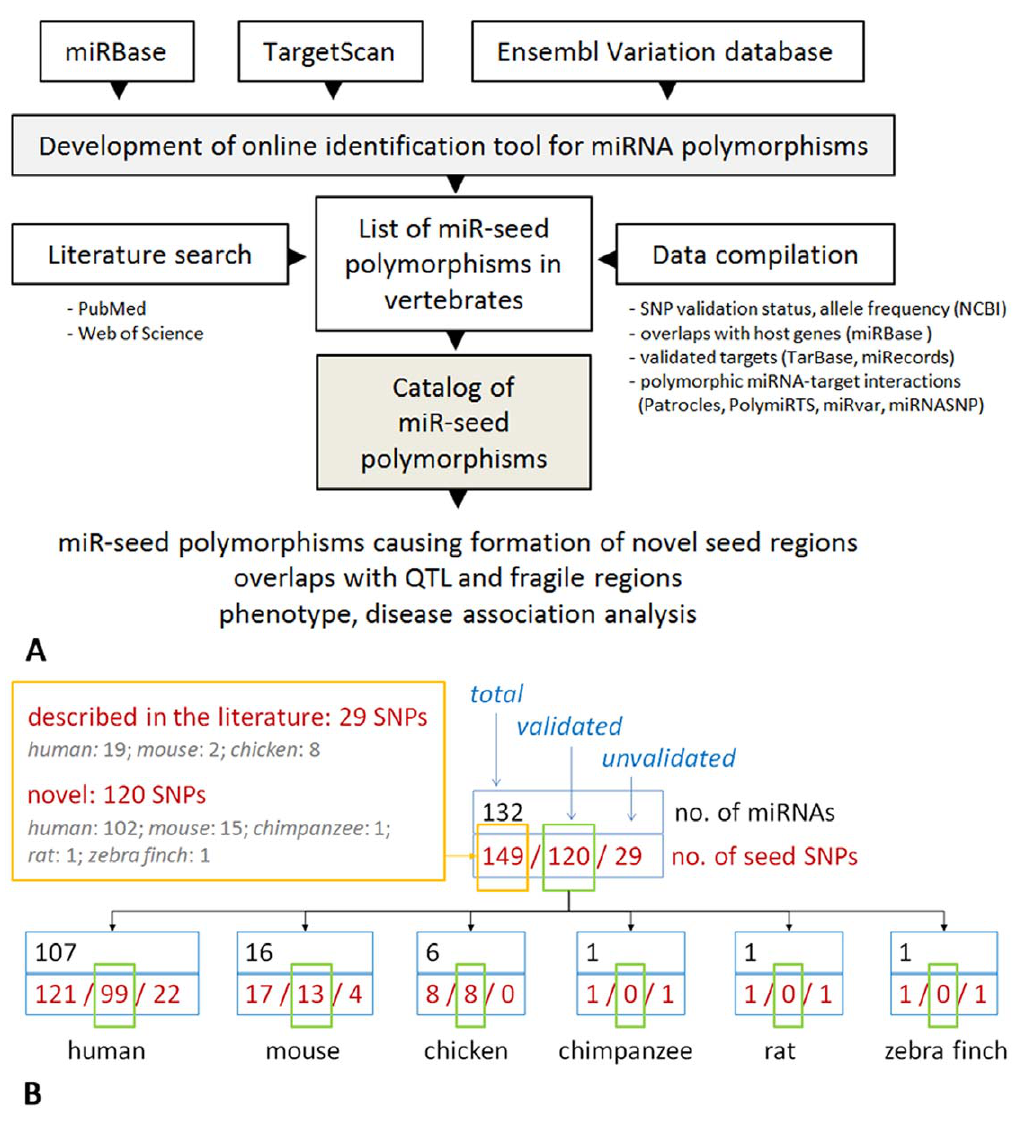
Figure 1. Workflow diagram of the study and diagram of assembled polymorphic miRNAs. ( A ) Workflow diagram of the study: approaches applied for search of known and novel seed miRNA variations and further bioinformatic analysis performed on the database of miR-seed polymorphisms. ( B ) Diagram of assembled miRNAs comprising miR-seed-SNPs according to source, validation status and species.